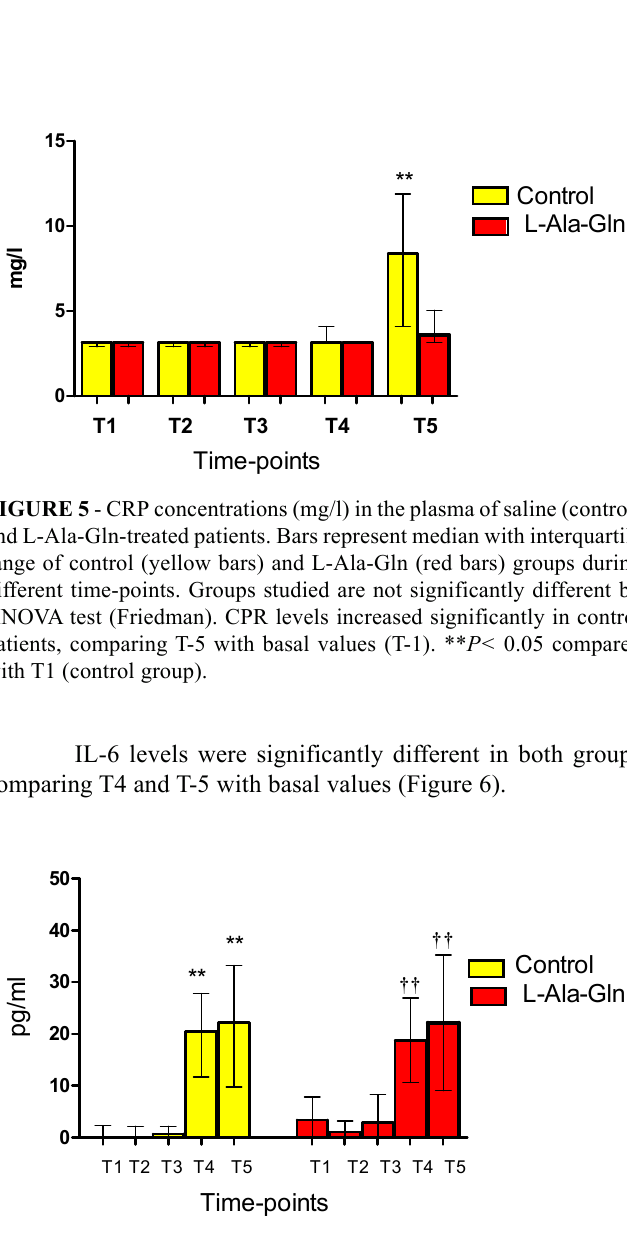
FIGURE 6 - IL-6 concentrations (pg/ml) in the plasma of saline (control) and L-Ala-Gln-treated patients. Bars represent median with interquartile range of control (yellow bars) and L-Ala-Gln (red bars) groups during different time-points. Groups studied are not significantly different by ANOVA test (Friedman). IL-6 levels increased significantly in control and L-Ala-Gln-treated patients, comparing T-5 and T4 with basal values (T-1). ** P< 0.01 compared with T1 (control group). †† P< 0.01 compared with T1 (L-Ala-Gln